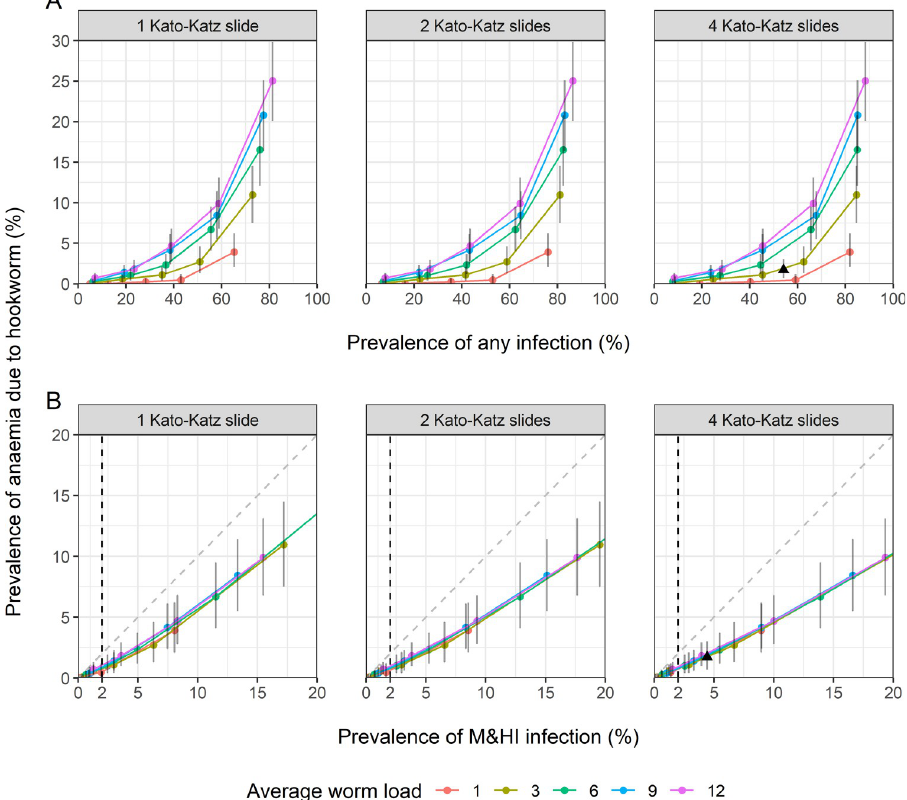
Fig 4. Estimated prevalence of anaemia attributable to hookworm in adult populations, for different infection prevalence scenarios. Predictions are displayed for different infection prevalence scenarios, defined by varying the probability ρ of having zero worms among the five values 0.1, 0.3, 0.5, 0.7, 0.9 (different bullets of the same colour) and the population mean worm burden (different colours). The shape parameter of the worm distribution across infected individuals is fixed to δ = 0.5 (as estimated from the Ugandan data). From left to right, the prevalence of any hookworm infection (A) and moderate-to-heavy intensity of infection (B) is based on 1, 2, 4 Kato-Katz slides, respectively. Each point (x, y) represents the mean predictions of infection prevalence (x-value) vs. hookworm- anaemia prevalence (y-value). The error band reports the 95% prediction interval (PI) of predicted hookworm- anaemia. The black triangle indicates the predictions (mean and 95%-PI) for the scenario resulting from the fit to the Ugandan dataset. Dashed vertical lines mark the WHO morbidity threshold of 2% moderate-to-heavy intensity prevalence. The bisector in panels (B) is added to visualise the robustness of the prevalence of moderate-to-heavy intensity of infection over the three sampling schemes.